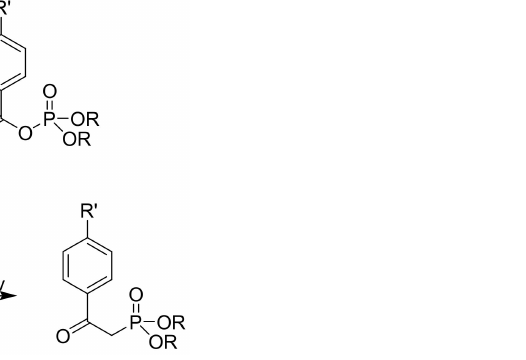
Scheme 18. Pathways for the reaction of 4-substituted α -bromo acetophenones with phosphites.